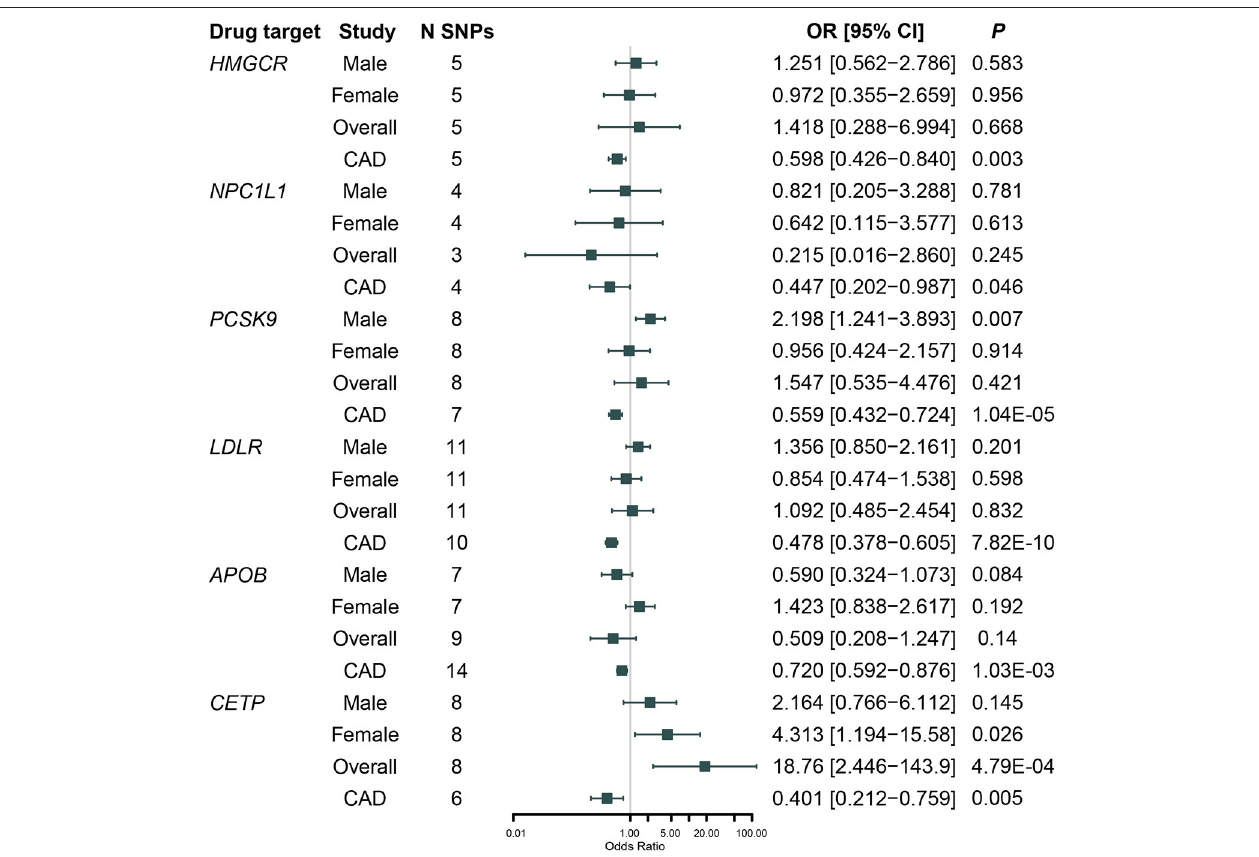
FIGURE 2 | Association between genetically proxied inhibition of 3-Hydroxy-3-Methylglutaryl Coenzyme A Reductase ( HMGCR ), Niemann-Pick C1-Like 1 (NPC1L1), Proprotein Convertase Subtilisin/Kexin Type 9 ( PCSK9 ), Cholesteryl Ester Transfer Protein ( CETP ), low-density lipoprotein receptor ( LDLR ), Apolipoprotein B ( APOB ) with renal cell carcinoma risk in NCI-1, IARC men and IARC women, and cardiovascular disease (CAD) risk in CARDIoGRAM after adjusted for weakly linkage disequilibrium (LD) among variants.